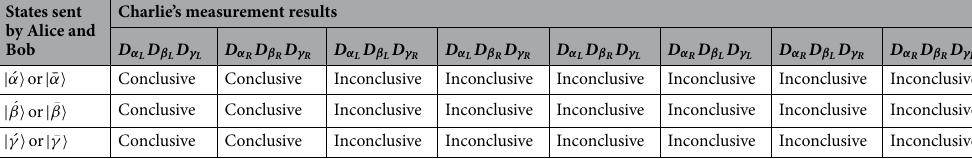
Table 3. The possible Bell state measurement results in the Brown Twiss scheme mode